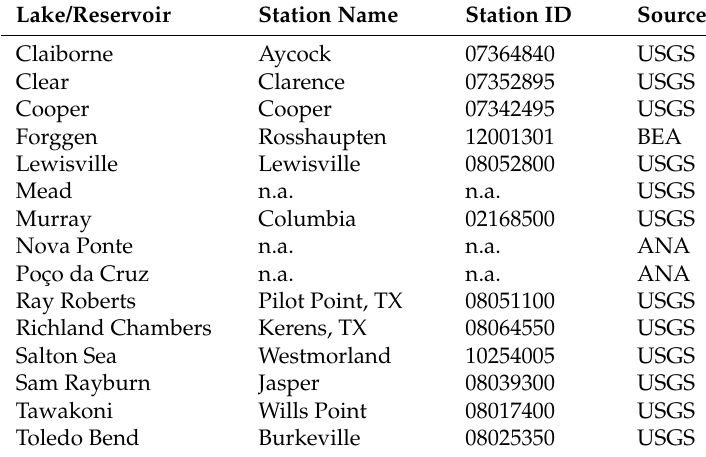
Table 2. List of used in situ